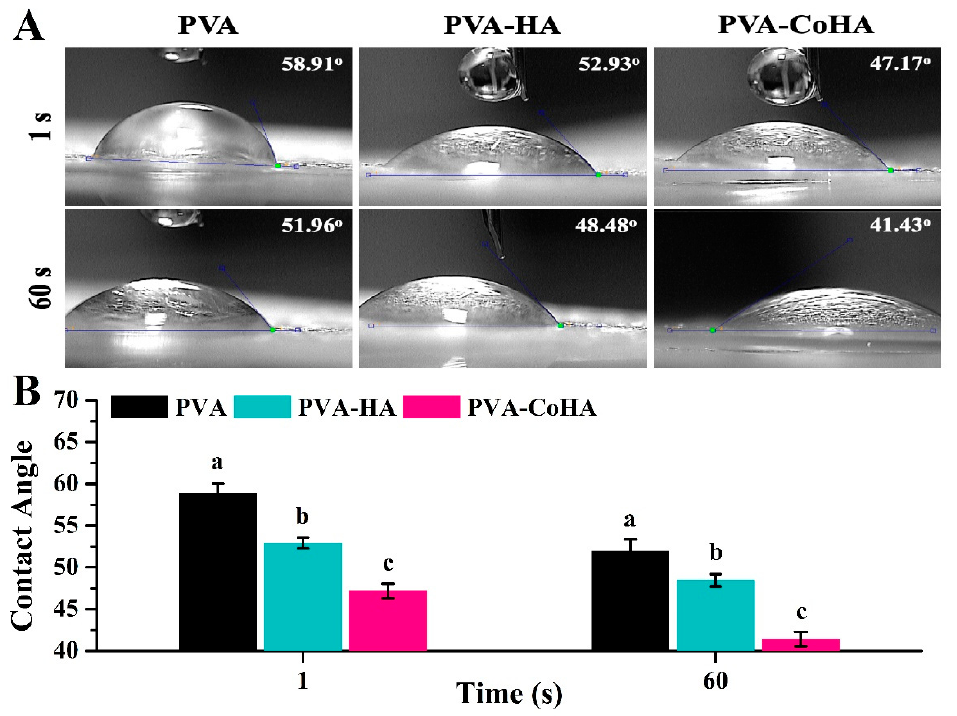
Figure 5. The surface wettability of PVA and PVA nanocomposites. ( A ) Image of surface contact angle. ( B ) Quantitative analysis of the contact angle was performed. Means with di ff erent letters (a–c) were significantly di ff erent ( p < 0.05, mean ± SD, n = 5).